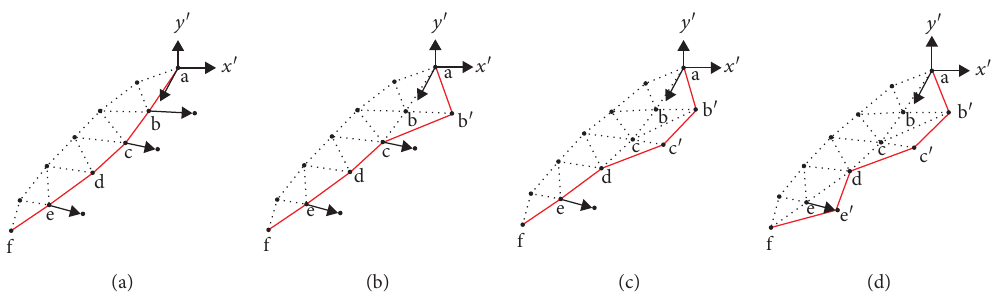
Figure 3: Geometric sketch of crack propagation [25].